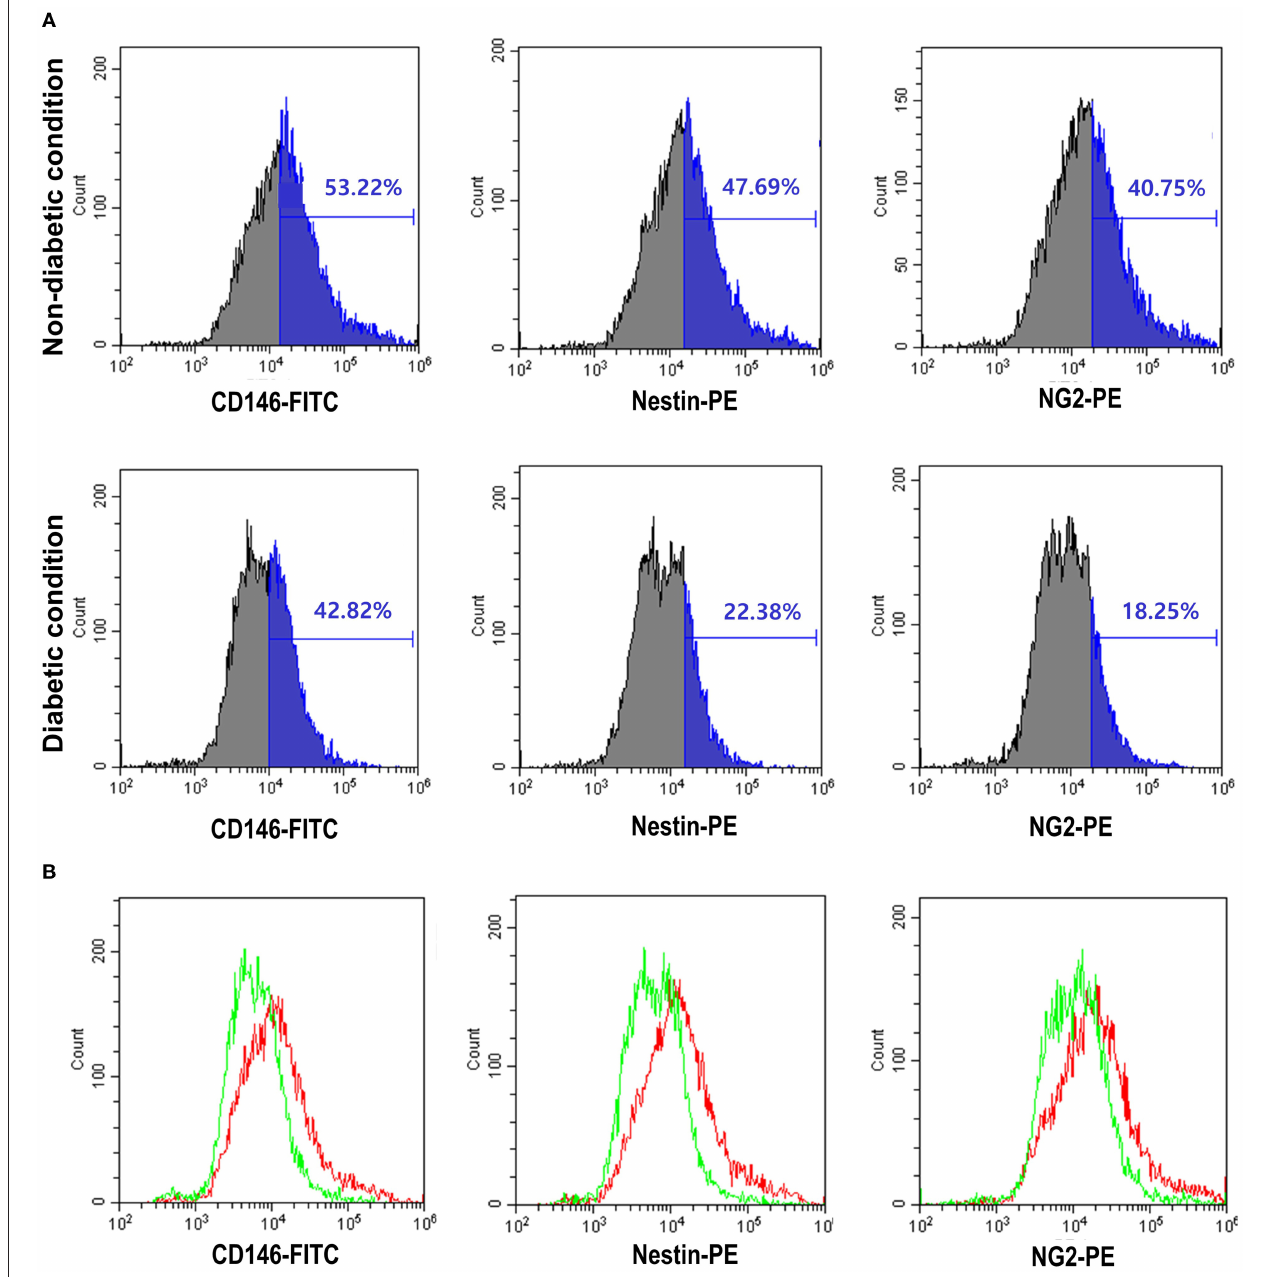
FIGURE 1 | The expression of pericyte markers by flow cytometry was reduced in the diabetic condition. (A) Analysis of pericyte surface markers in the non-diabetic and diabetic conditions using flow cytometry [CD146-fluorescein isothiocyanate (FITC), Nestin-phycoerythrin (PE), and NG2-PE]. The results provided here are representative of those obtained in three independent studies. In the diabetic condition, Nestin and NG2-PE were seen to decrease by more than half. (B) Overlay of diabetic condition (green line) and non-diabetic (red line) condition flow cytometry. The diabetic condition showed the three pericyte markers to be